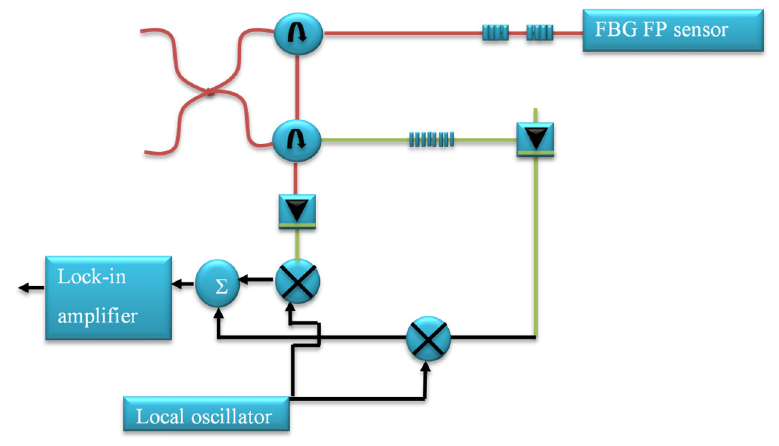
Figure 4. Fabry–Perot and quadrature recombination technique for AE monitoring [48].